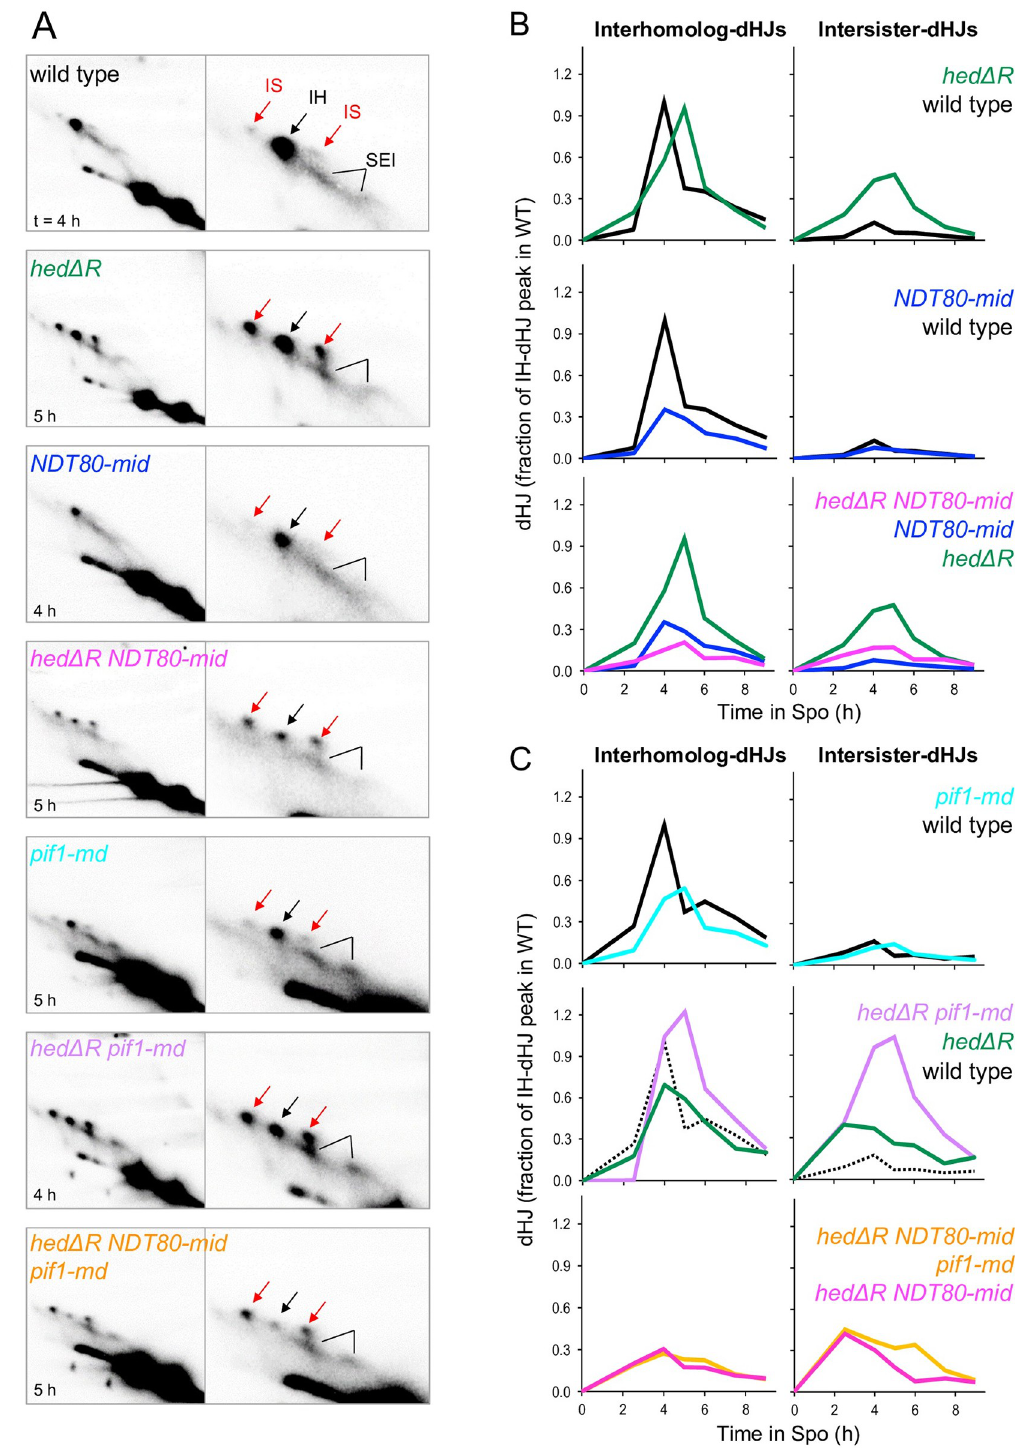
Fig 5. The meiotic recombination checkpoint promotes Rad51-mediated dHJ formation. (A) Excerpts of representative two-dimensional gel Southern blot analyses at the time of maximum joint molecule levels in WT, hed Δ R , NDT80-mid , hed Δ R NDT80-mid , pif1-md , and hed Δ R NDT80-mid pif1-md . Right panels show enlarged excerpts of left panels. Interhomolog dHJs (black arrow), intersister dHJs (red arrows), interhomolog and intersister SEIs (black lines). (B) Quantitative analysis of effects of hed Δ R and NDT80-mid on IH-dHJs (left) and IS-dHJs (right; time course tc17-1). Joint molecule (JM) levels are expressed as